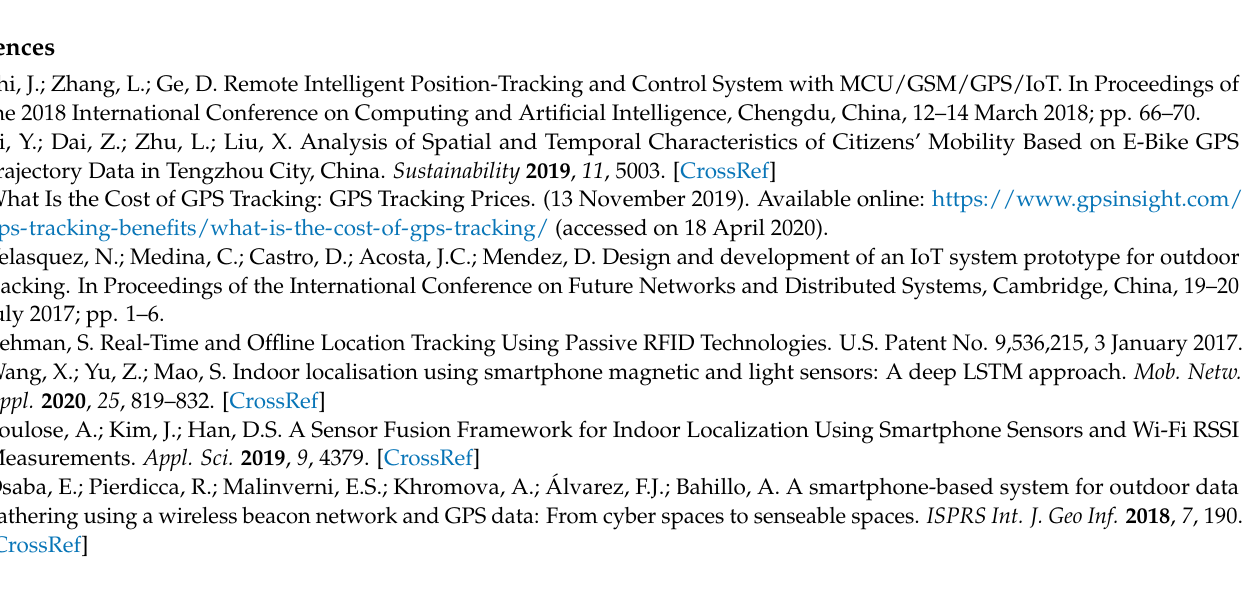
Sign up view of Institutional user. Figure S5: Sign up view of traveller. Figure S6: Navigation view of traveller. Figure S7: Route history of created path. Figure S8: List of Surface maps. Figure S9: List of Surface maps. Figure S10: Other user’s shared path list. Figure S11: Another created path in a remote area, Video S1: Create Surface map. Video S2: Create route path share with others. Video S3: Search Shared Surface